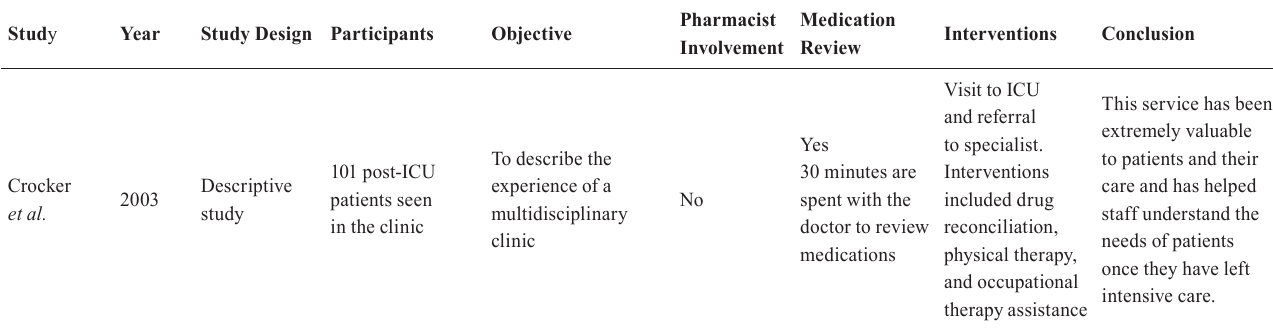
TABLE I - S ummary of the literature related to pharmacist contributions or medication review for post-ICU survivors